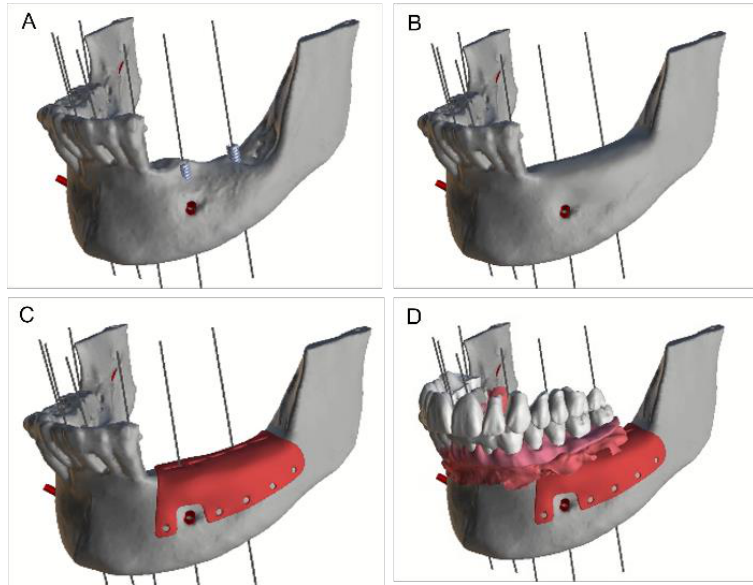
Figure 4. Virtual planning of the first case (phase 2). Ideal choice of the fixtures position and dimensions ( A ); simulation of the bone volume regeneration according to the final result prediction ( B ) and titanium membrane design ( C , D ).